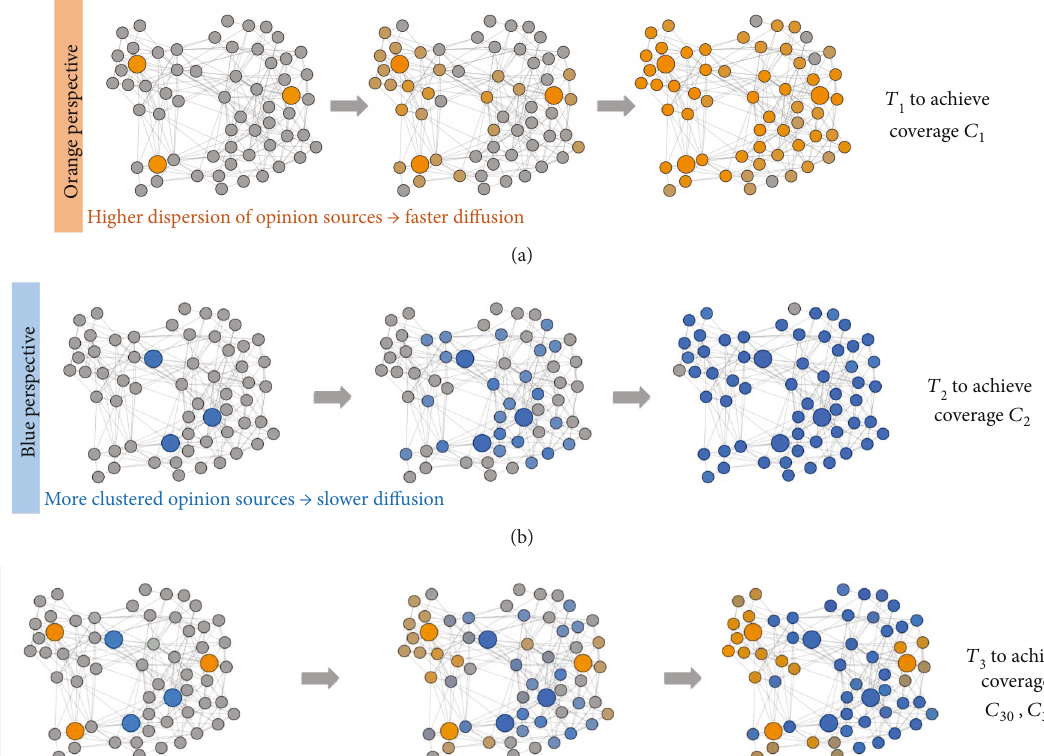
Figure 1: Example of the incurred limitations when benchmarking a di ff usion process only from a single opinion ’ s point of view, when the real-world context implies simultaneous di ff usion and competition between multiple opinions. It is suggested that the orange di ff usion time is shorter (better) than the blue T time, due to the higher, more uniform dispersion of orange opinion sources. However, in reality (c), T 1 2 none of the two opinions may fully cover the network in optimal times T ≈ T ≈ C that is, T < T and C > C , C 1 2 3 1 2 3 o 3 b